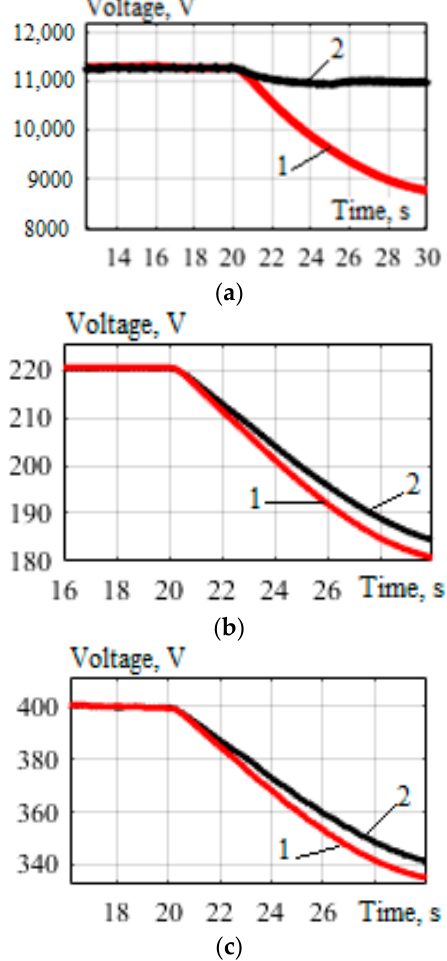
Figure 9. Time dependencies of voltages: ( a ) on the HV side of PR; ( b ) on the LV side of PR (DC grid); ( c ) on the LV side of PR after inverter (in AC grid); 1—non-regulated PRs; 2—regulated PRs.